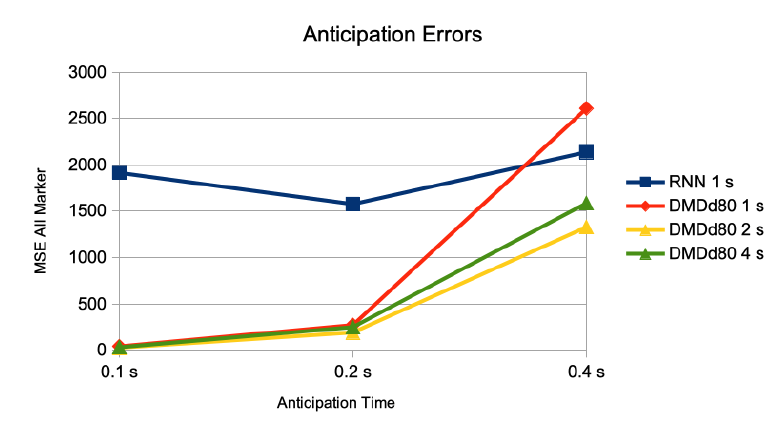
Figure 2. Comparison of anticipation errors for anticipations of 0.1s (5 frames), 0.2s (10 frames), and 0.4s (20 frames). The result of a trained RNN using inputs of 1s, and DMDd80 on inputs of 1 s, 2s, and 4s. The error measure is the average of the mean squared error on the pose sequences on the different motion classes of the Human 3.6M dataset for actor